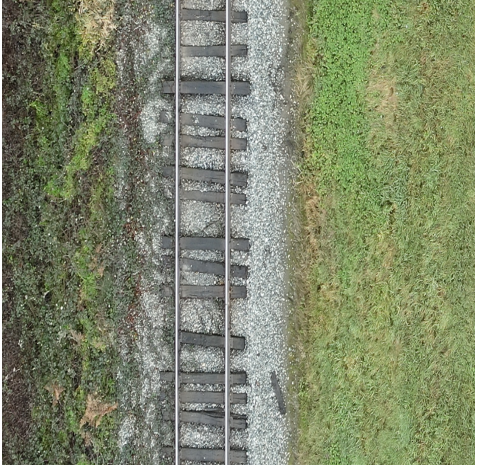
Figure 19. Negative missing tie